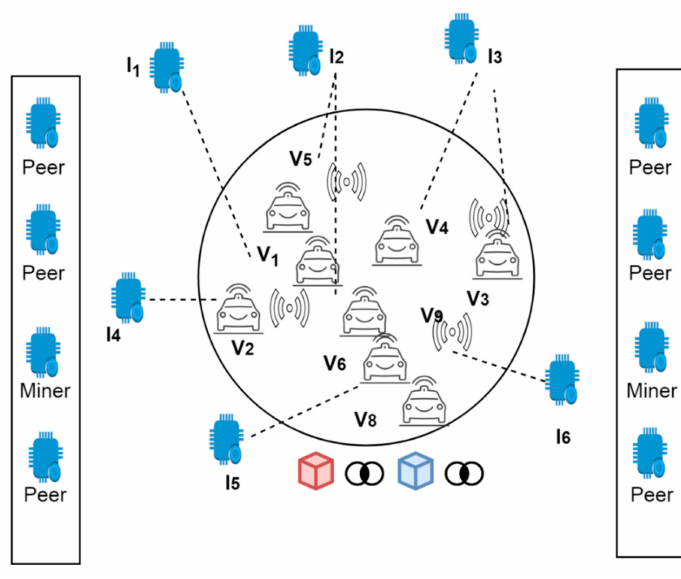
Figure 1. The blockchain